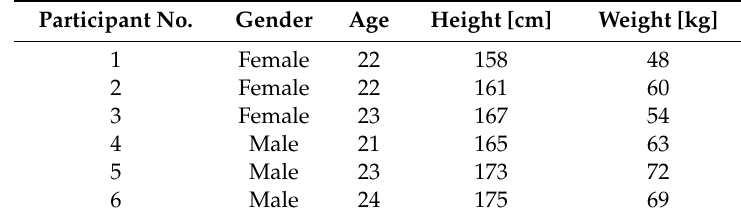
Table 4. Information of 6 participants.